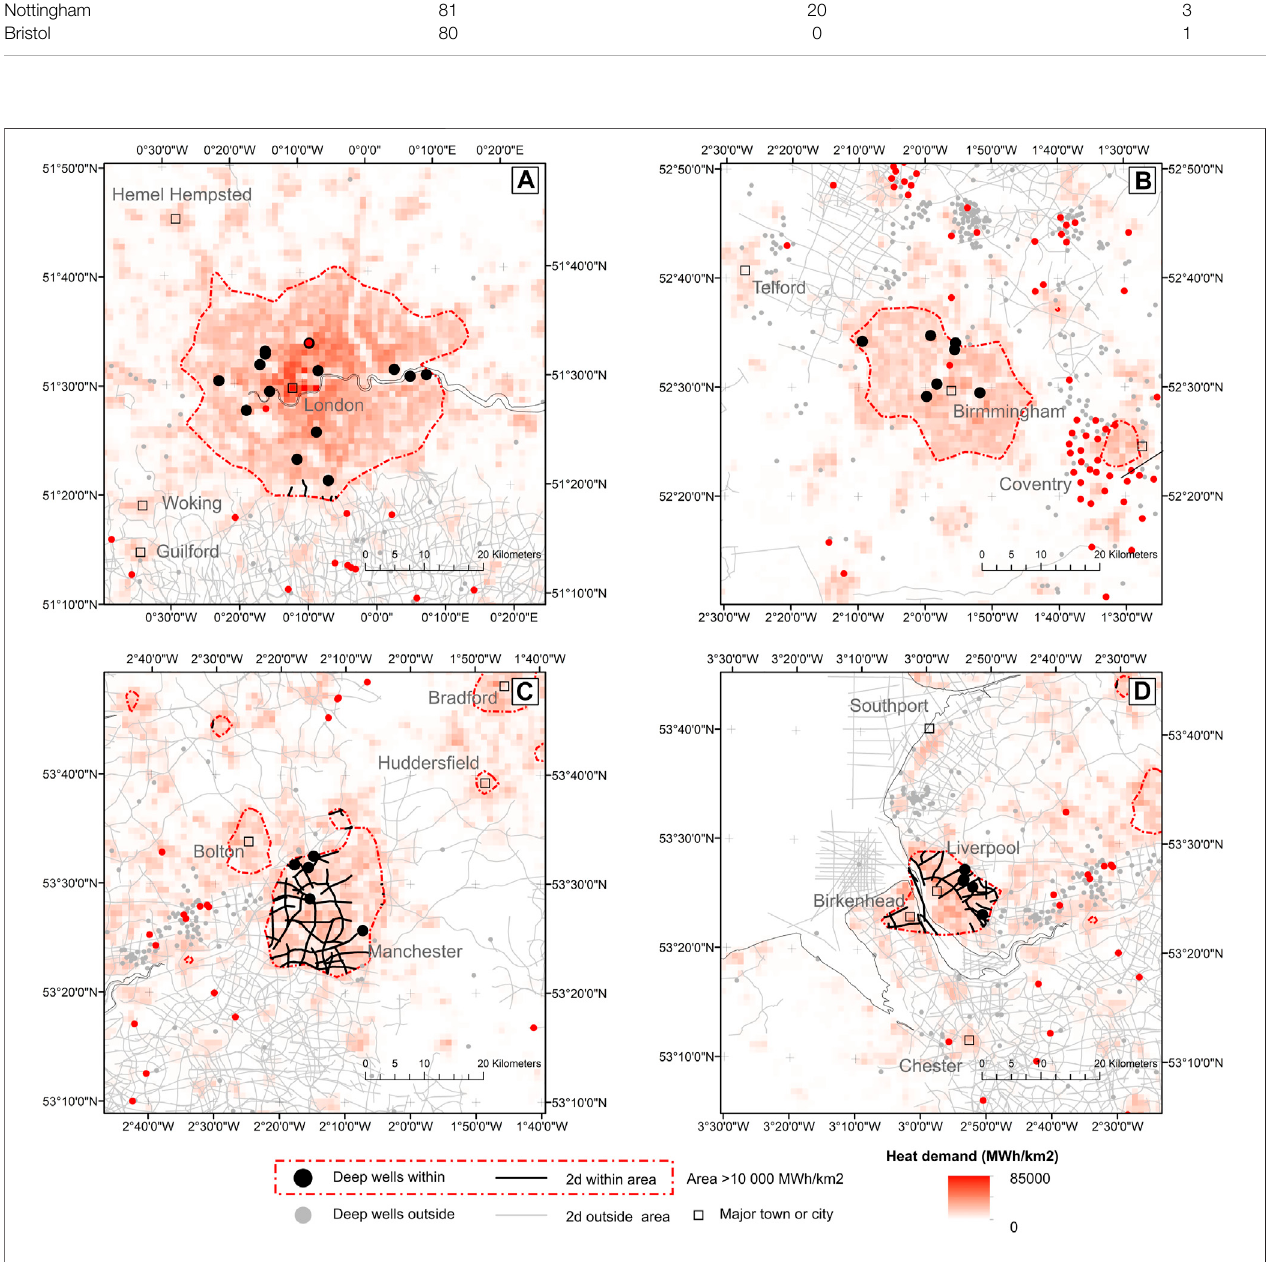
Frontiers in Earth Science |